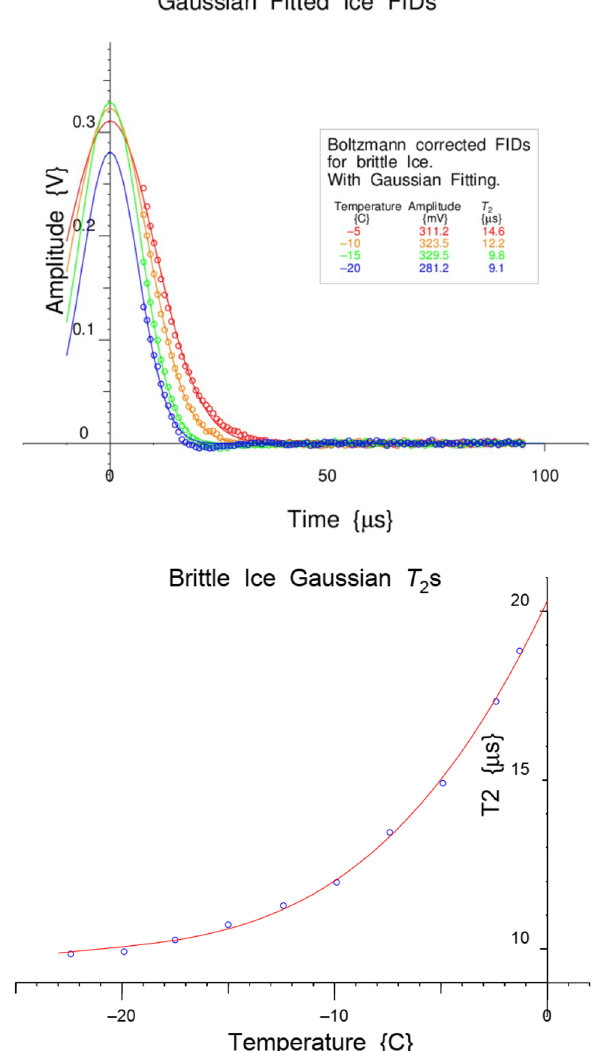
Fig. 8 The lab-tools NMR spectrometer is shown with variable-tem- perature NMR Probe, with the Peltier thermo-electric cooling ele- ments in the white box. The room-temperature liquid waste heat removal circuit can be seen on the right